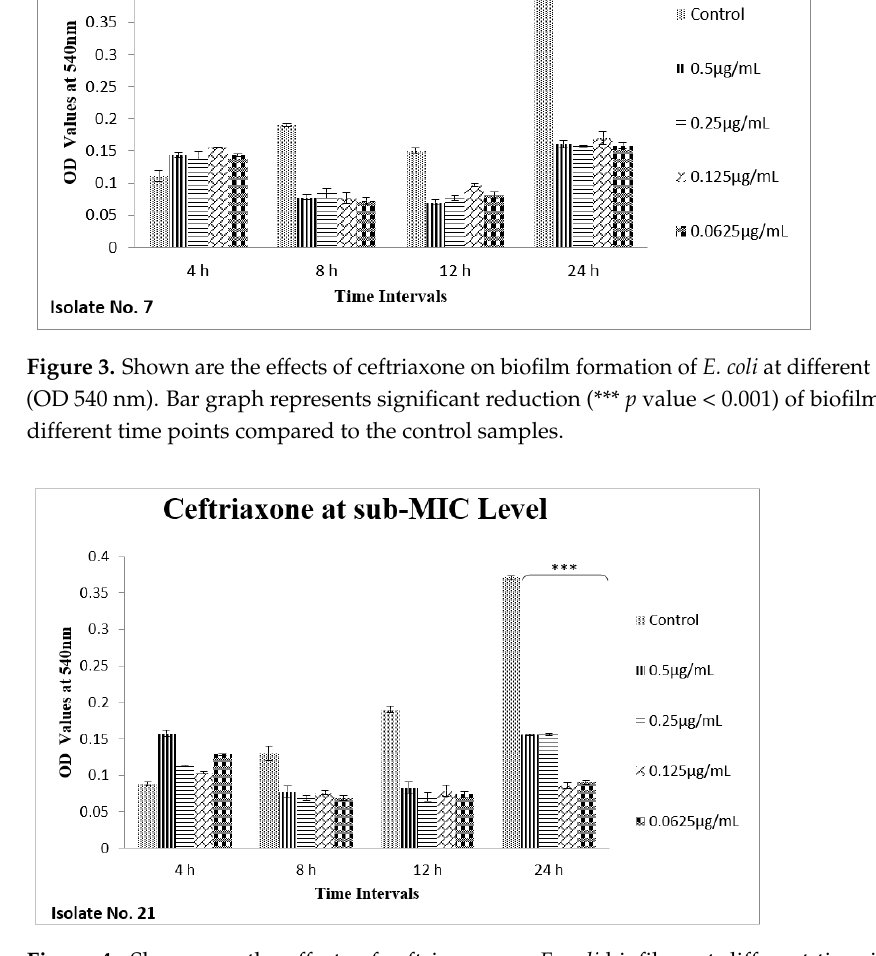
Figure 5. Shown are the effects of enrofloxacin on bacterial biofilm at different time points (OD 540 nm). Bar graph represents significant reduction (* p value < 0.05) in biofilm formation after 24 h of incubation when compared to the control samples.